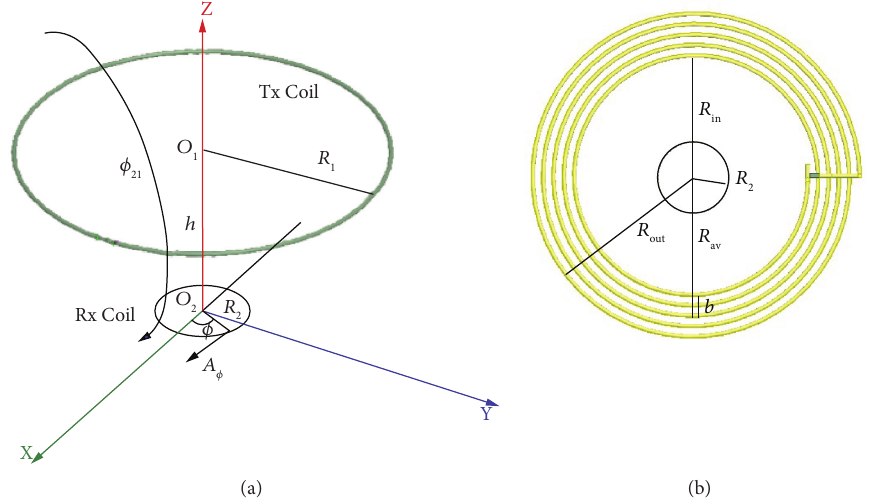
Figure 1: (a) The inductive link system model with a single-turn Tx coil. (b) The planar spiral circular Tx coil in HFSS